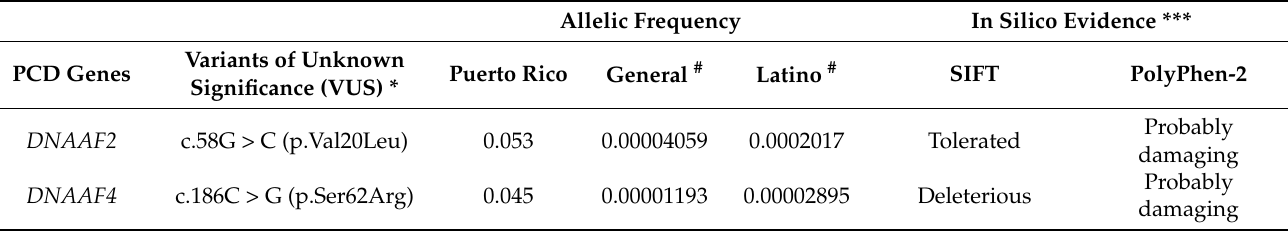
Table 2. Frequency of PCD genes with VUS in Puerto